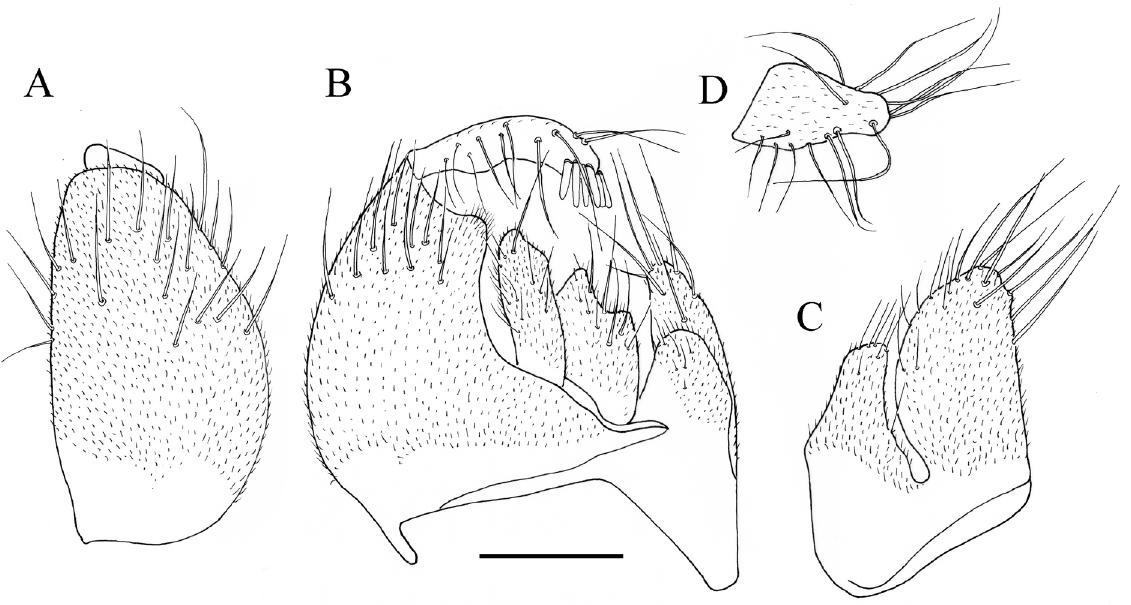
Fig. 13. Terminalia of Tachydromia semiaptera (Gil Collado, 1923) (RBINS). A . Right surstylus and right epandrial lamella. B . Epandrium with cerci. C . Left epandrial lamella and left surstylus. D . Right surstylus. Scale bar: 0.1